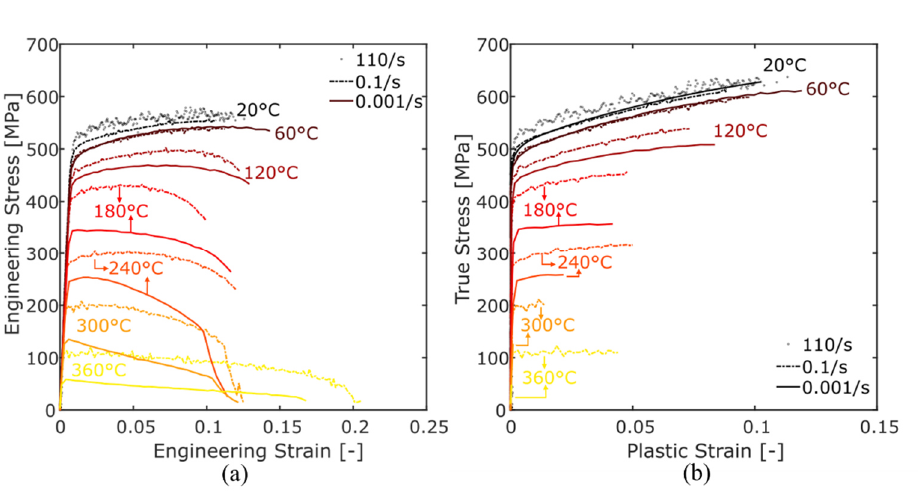
Fig. 2. (a) Engineering stress-strain curves from uniaxial tensile tests at various temperatures. The low speed tests are highlighted as solid lines. The intermediate speed tests are plotted in dashed lines and the high strain rate tests are marked in dots. (b) True stress-plastic strain curves from uniaxial tensile tests at various temperatures. The curves are truncated at the point of force maximum (uniform